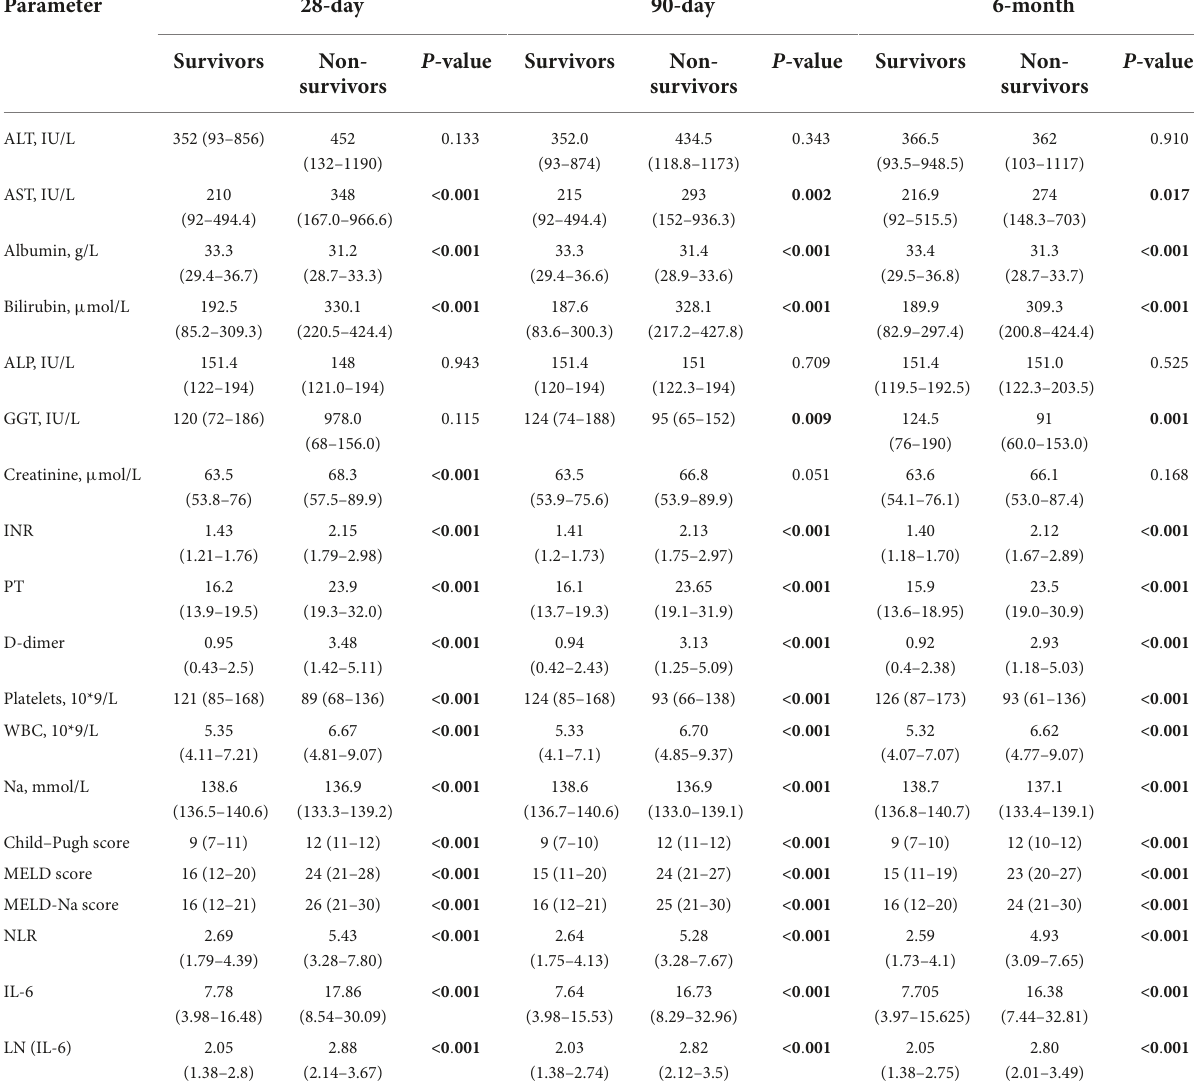
TABLE 2 Comparing the laboratory characteristics between non-surviving groups and surviving